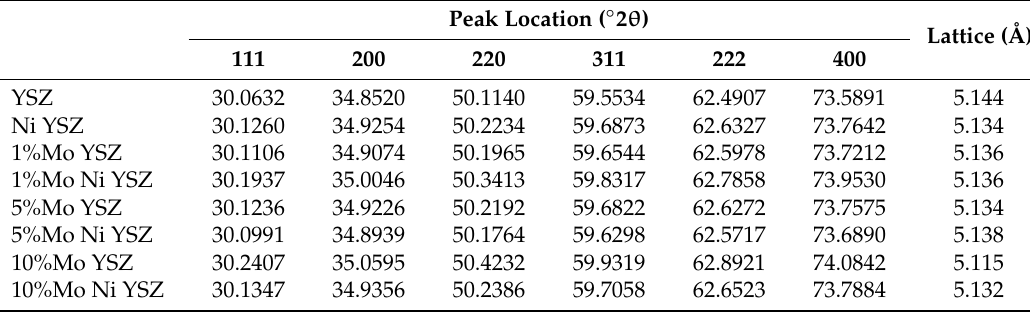
Table 2. XRD peak locations determined according to Rietveld refinement, and associated lattice parameters of resulting structure assuming cubic